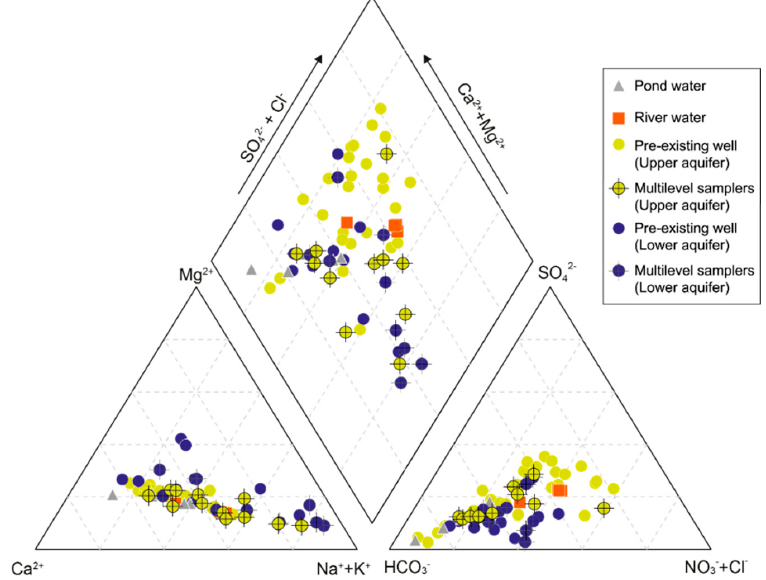
Figure 3. Piper’s diagram of surface and ground water samples (n = 66) in the study area.